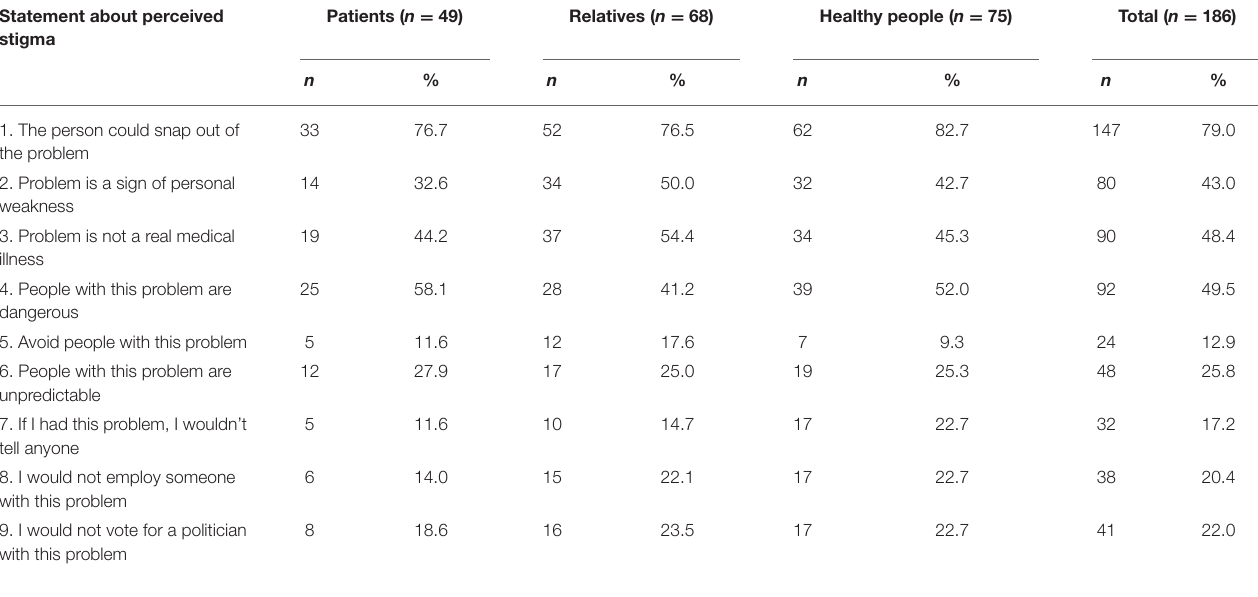
TABLE 3 | Compared on each statement about other people’s attitudes toward the person in vignette. Statement about perceived stigma